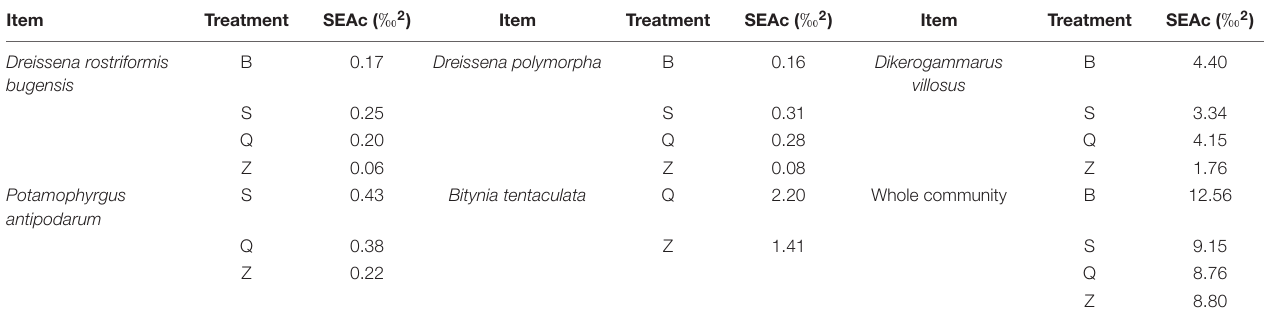
TABLE 3 | Sample size-corrected standard ellipse areas (SEAc) of five newly settled macro-invertebrates and whole community from the four different treatments. 2 ) Item Treatment Item Item Treatment SEAc ( (cid:104)